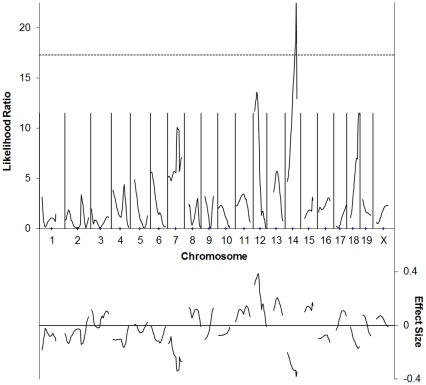
C57BL/6J×129P3/J F2 cross simple interval mapping.Whole genome simple interval map. Top: likelihood ratio statistic or likelihood of a region being linked to bFGF-induced corneal neovascularization. Dashed line indicates P = 0.05 as determined by bootstrapping. Bottom: predicted additive effect of a region on bFGF-induced corneal neovascularization.